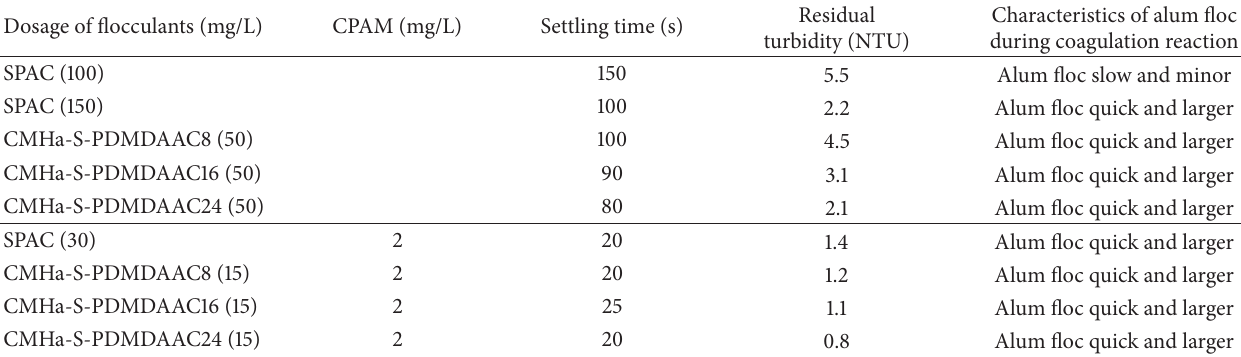
Table 11: The coagulation behaviors of CMHa-S carried different dosage of PDMDAAC (1000NTU diatomite suspension). Dosage of flocculants (mg/L)